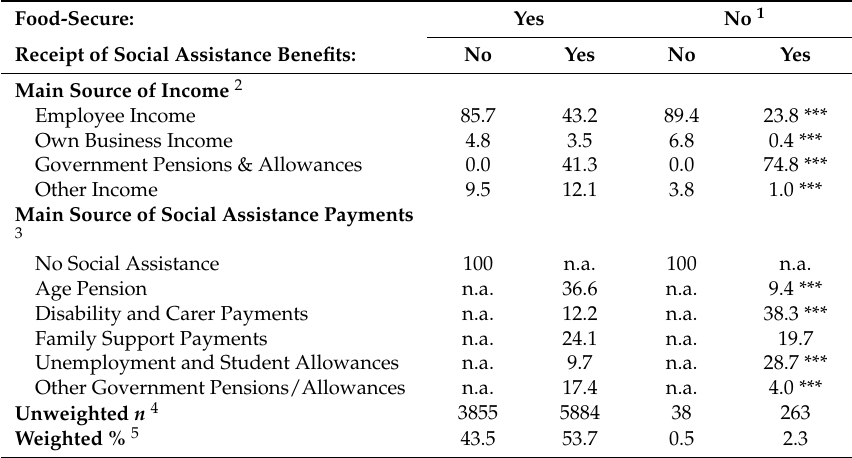
Table 1. Food insecurity and receipt of social assistance, by main source of income and source of social assistance—households, weighted (%),